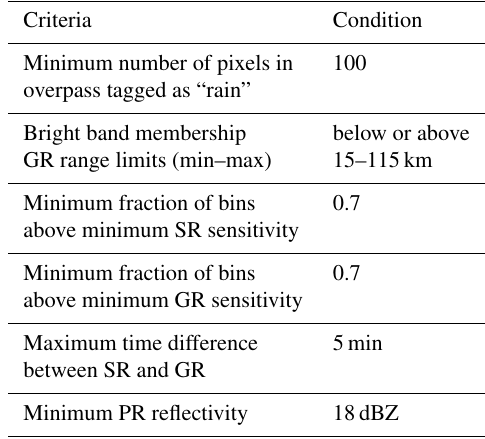
Table 2. Filtering criteria for the matching workflow. Criteria Condition Minimum number of pixels in 100 overpass tagged as “rain” below or